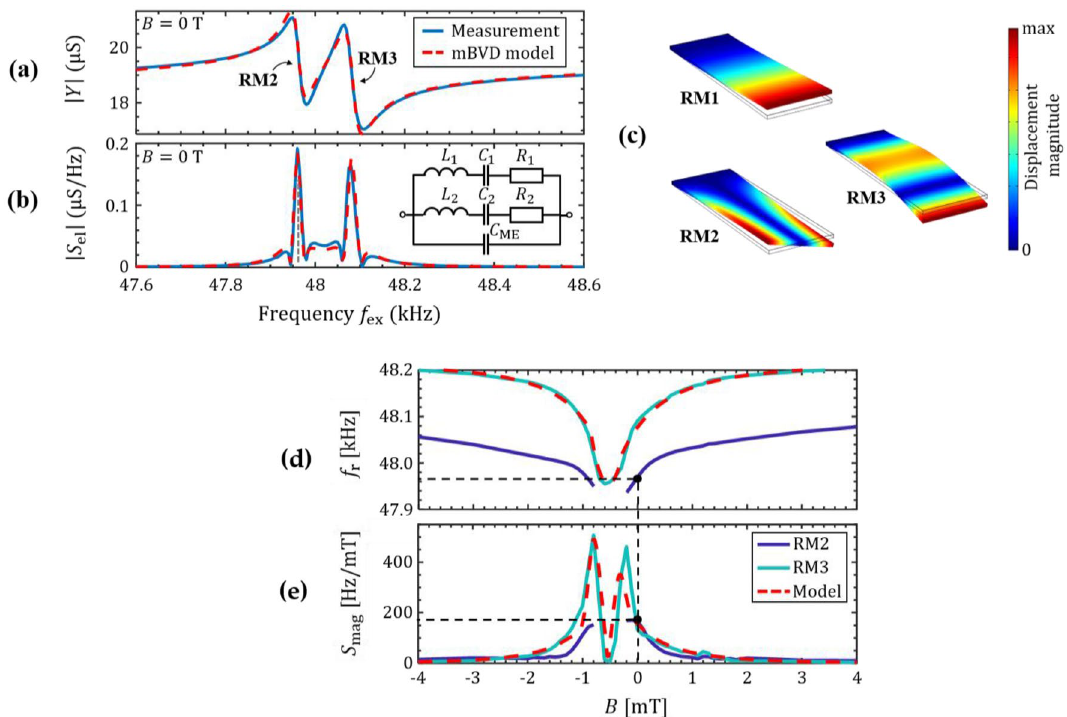
Figure 3. Sensitivity of delta-E operation. ( a ) Measured and modeled electrical admittance of the sensor at B = 0 and ( b ) the absolute of its derivative. The modified BVD equivalence circuit used for the fit is shown as inset and the resulting values are given in Table 1. ( c ) Solutions of the finite element study for the first three resonance modes (RM1-RM3) with eigenfrequencies f r,1 < f r,2 < f r,3 , ( d ) Simulation and measurements of the resonance frequencies and ( e ) its first derivative the magnetic sensitivity S mag , as a function of the magnetic bias field applied along the x-axis. The black, dashed lines mark the frequency of operation at zero bias and the corresponding magnetic sensitivity S mag and resonance frequency. The measurement was started in the negative magnetic field regime along the cantilever’s long